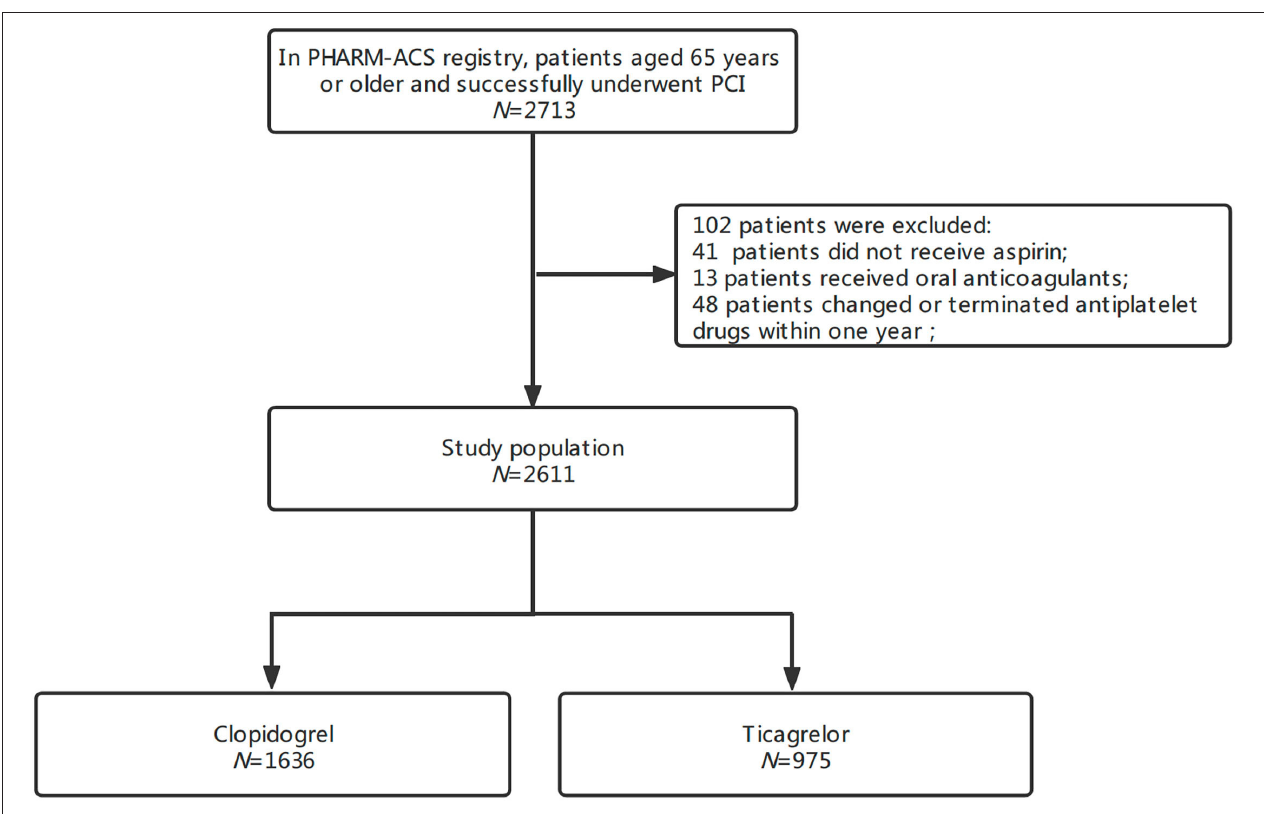
FIGURE 1 | Study flowchart. ACS, acute coronary syndrome; PCI, percutaneous coronary intervention.